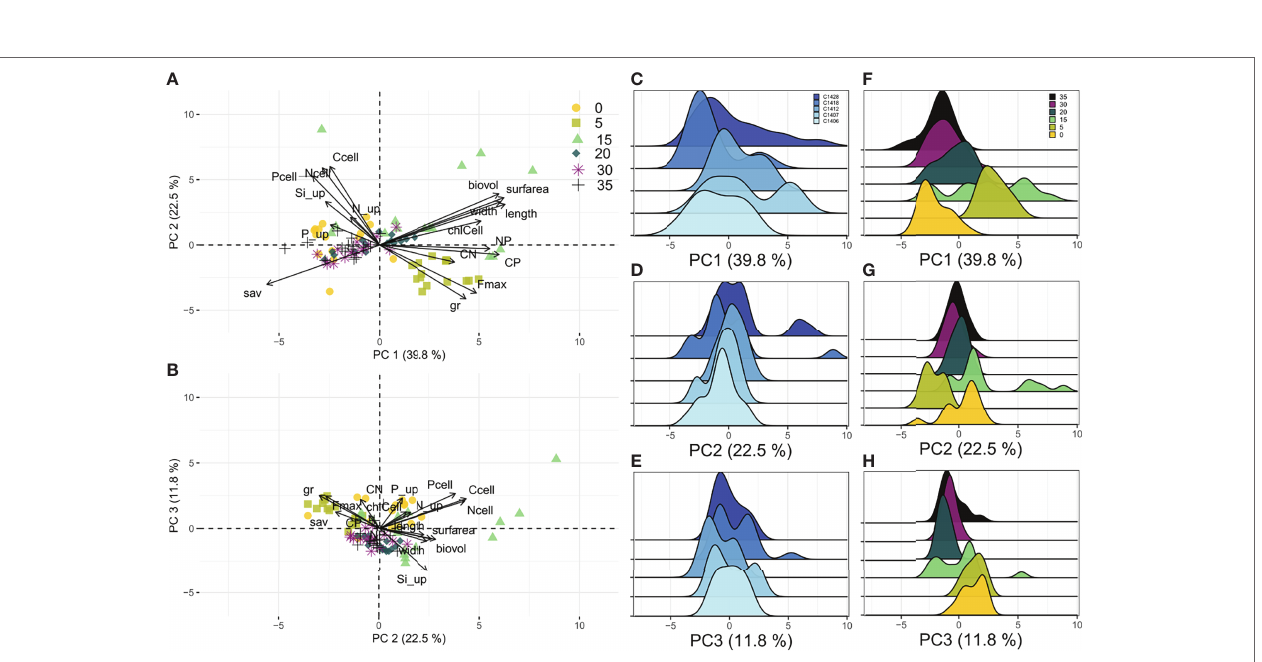
FIGURE 4 | Results of PCA for S. marinoi strains grown under six salinity levels. (A, B) Ordination plots summarizing the variation of traits in all experimental units. (C–E) Individual loading grouped by strain along the first three principal component axes. (F–H) Individual loading grouped by salinity along the first three principal component axes. Traits abbreviations as in Table 1